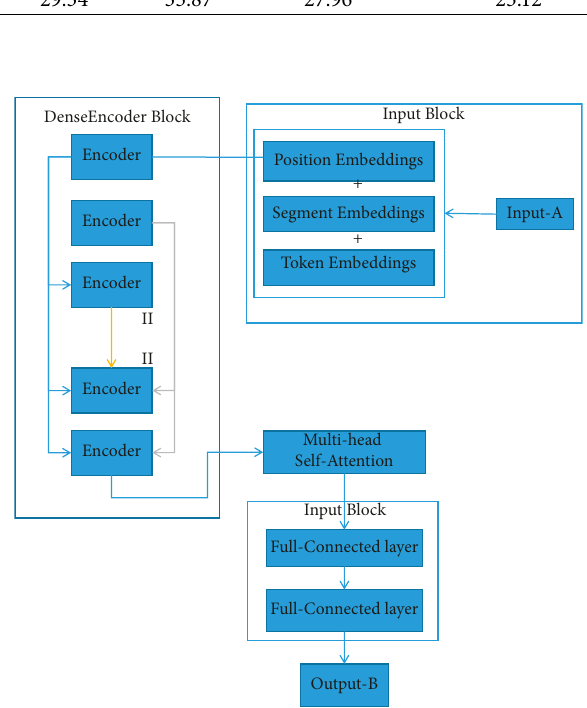
Figure 5: Basic model, used for sentence selection, evidence prediction, and answer